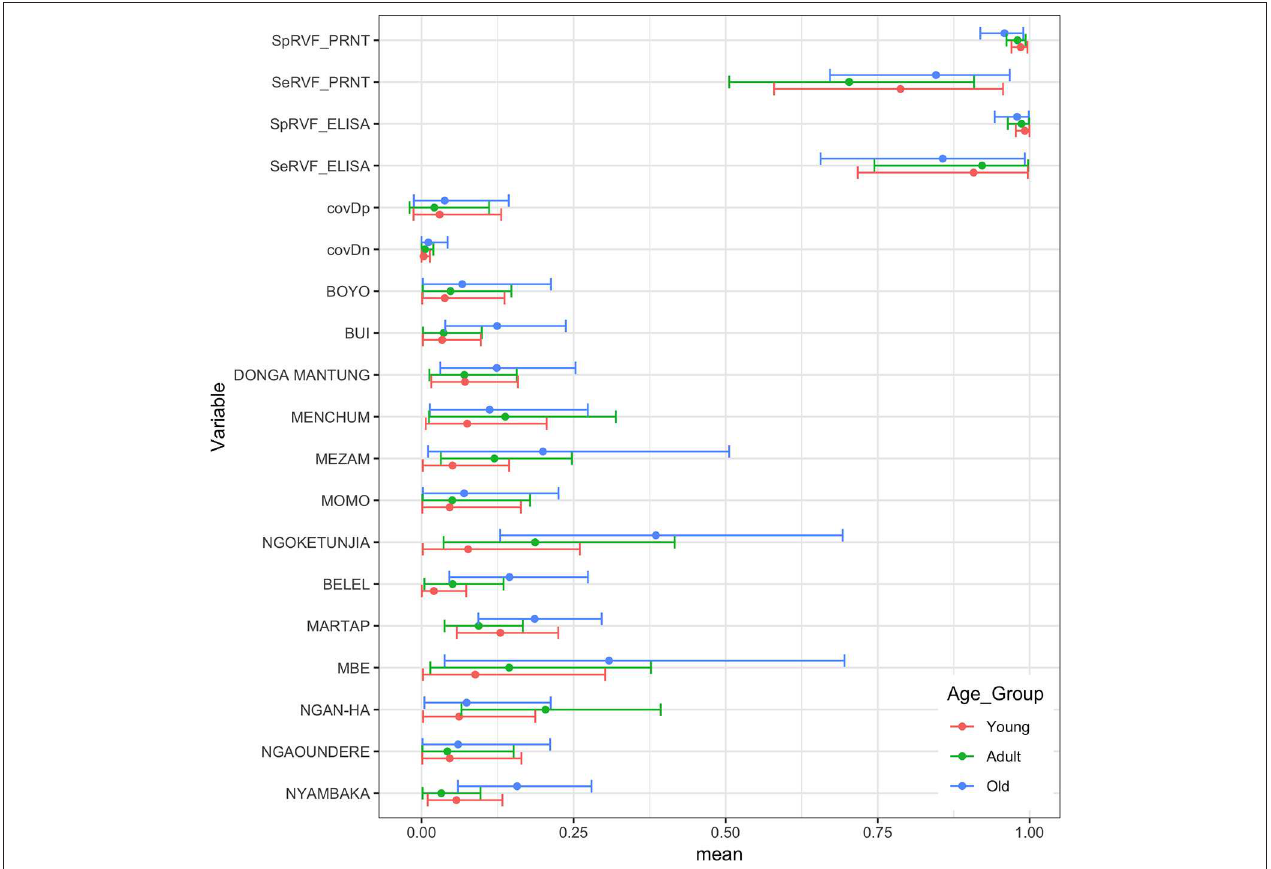
FIGURE 5 | Bayesian mean and 95% BCI parameter estimates for the ID.Vet RVF ELISA (cut-off 40pp) and the RVF PRNT80 (cut-off 80) estimated independently in the three age classes of cattle in Cameroon and the age class specific seroprevalence estimates across the 13 subpopulations.